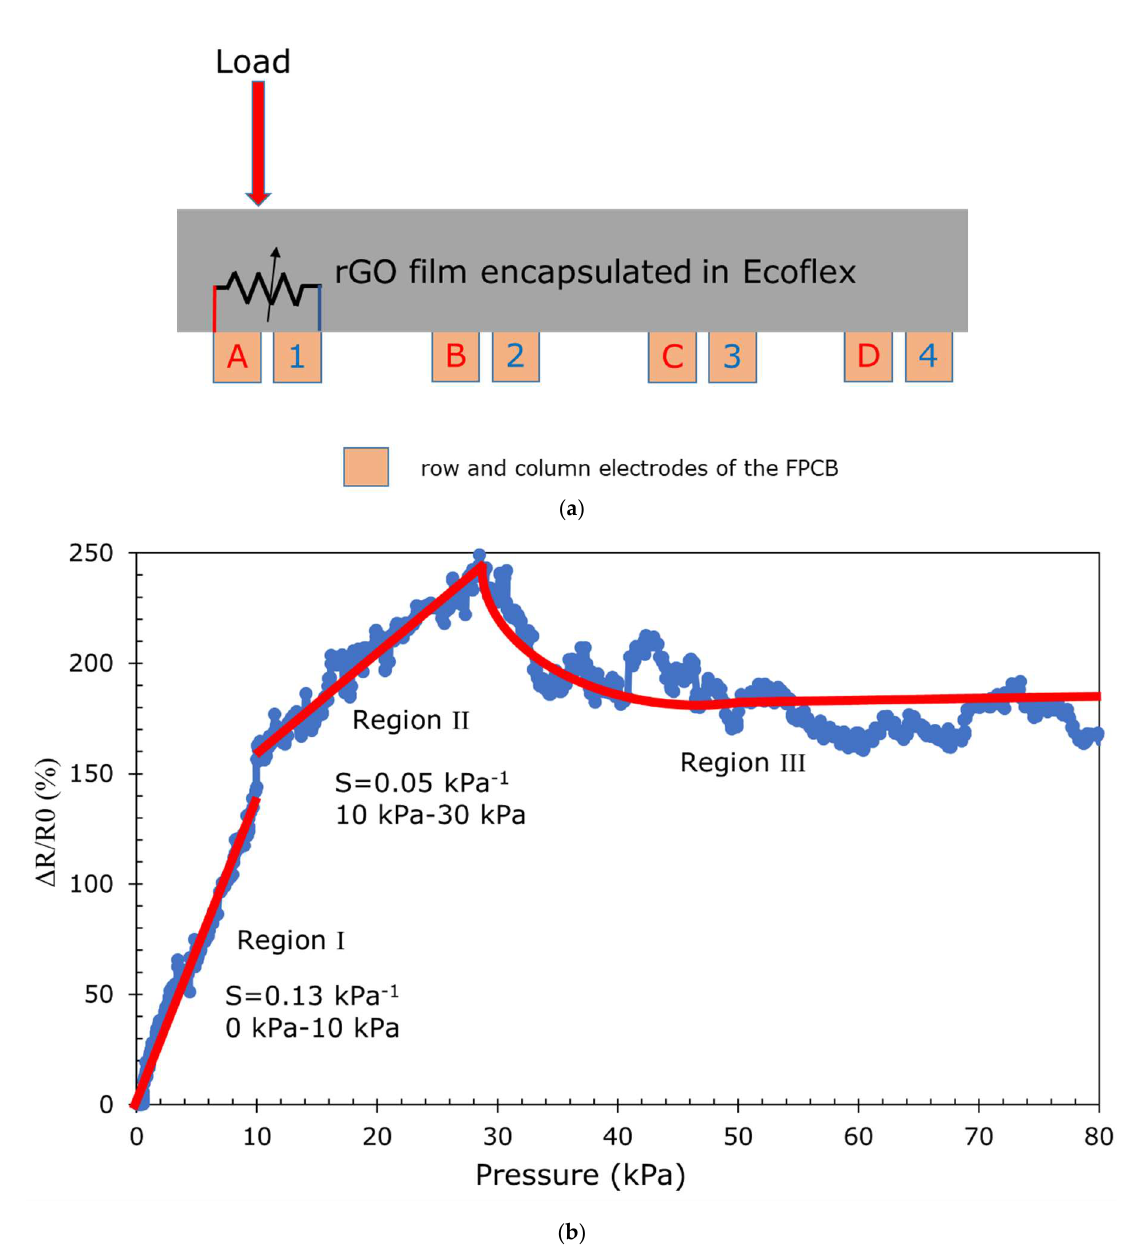
Figure 4. ( a ) A cross-section of the sensor showing four sensels, ( b ) relative resistance change in the sensor with pressure showing three different regions.